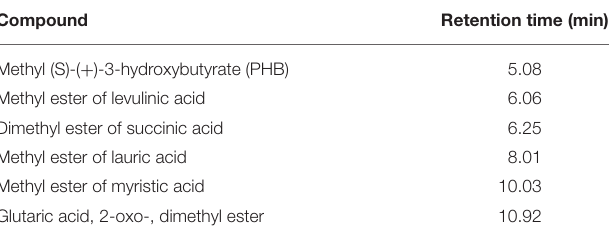
TABLE 4 | Compounds present in bioreactor fermentation samples, identified by GC-MS.